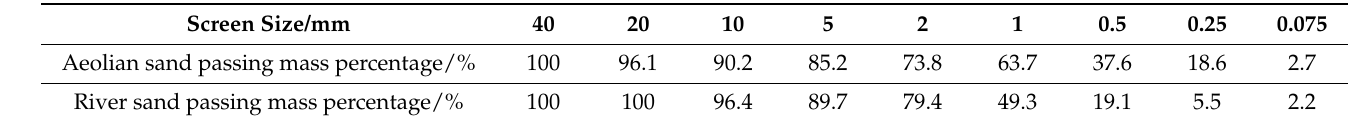
Table 2. Particle analysis results.